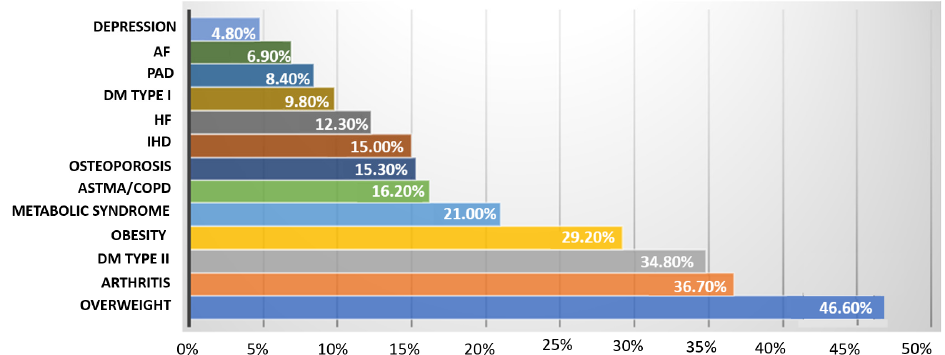
Figure 5. Comorbidities (IHD—ischemic heart disease; HF—heart failure; AF—atrial fibrillation; PAD—peripheral arterial disease; DM—diabetes mellitus; COPD—chronic obstructive pulmonary disease).